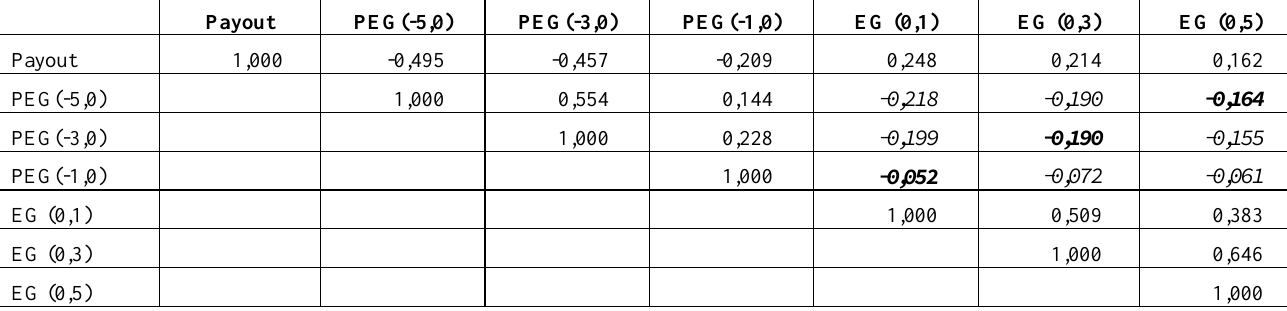
Table 5: Correlations between dividend payout, past and future earnings growth